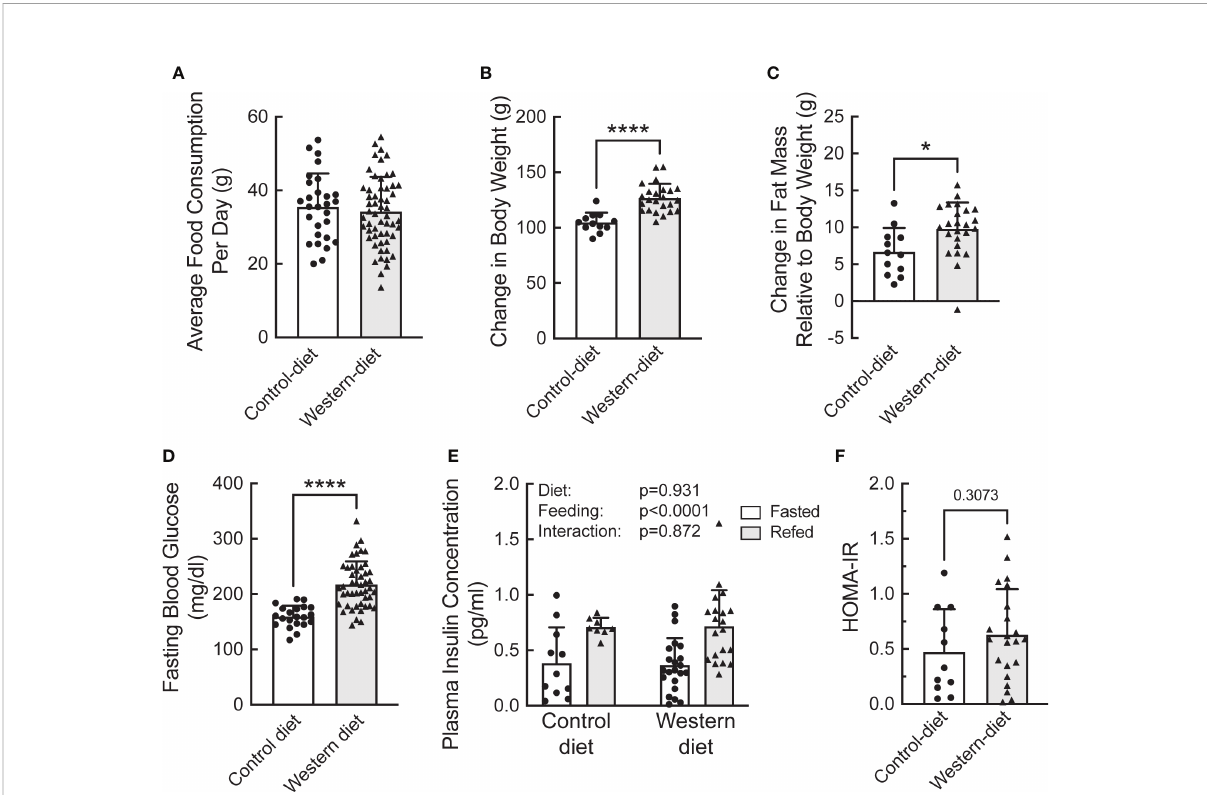
FIGURE 4 Characterization of the effect of short-term (2 week) consumption of a Western diet on (A) average daily food consumption, (B) change in body weight, (C) change in fat mass, (D) fasting blood glucose concentration, (E) plasma insulin concentration, and (F) HOMA-IR. (A – D) N=12 (control diet) or 22 (Western diet) rats/group; (E) N=6 (control diet) or 9 (Western diet) rats/group. *p<0.02, **** <0.0001 vs control